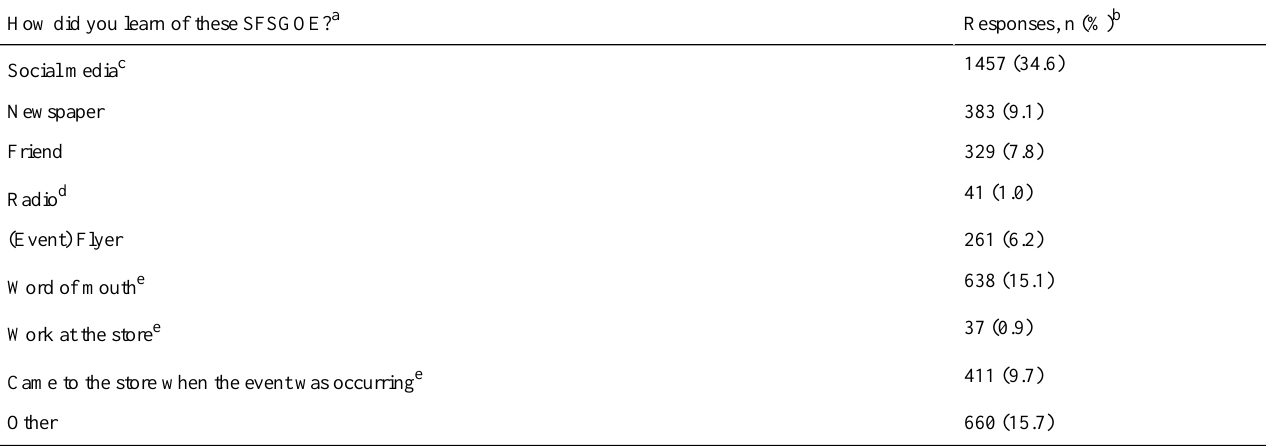
Table 2. Proportion of participants’ responses as to how they learned about Safe Firearm Storage Giveaway Outreach Events (SFSGOE) 2014-2018 based on the intake